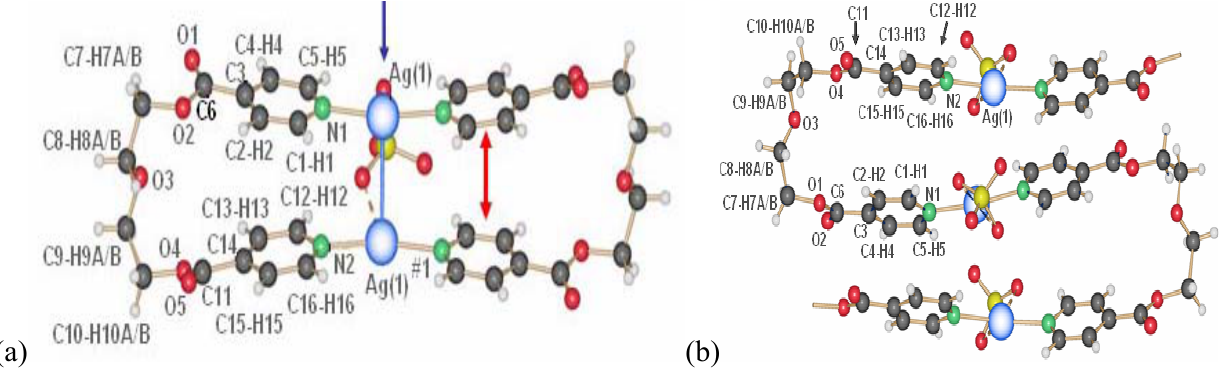
Figure 9. (a) metalla-cyclic compound 8 with short metal-metal-contacts and  - 